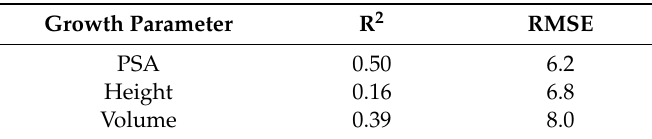
Table 1. Coe ffi cient of determination (R 2 ) and root mean square error (RMSE) values from the linear regressions between weed biomass and triticale projected shoot area (PSA), height, and volume values that were extracted by the UAV in the field